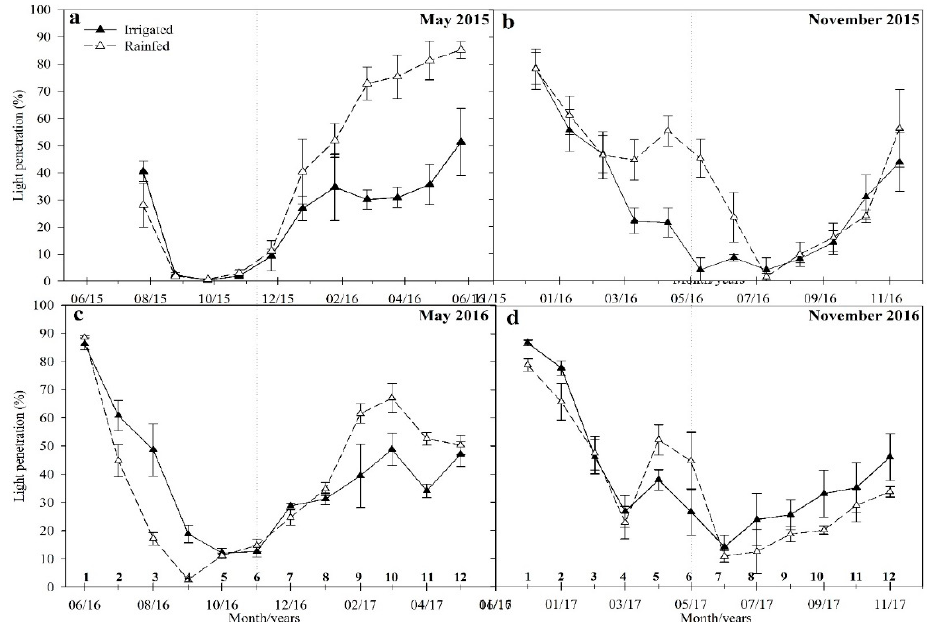
Figure 5. Light penetration of Rayong 9 cassava under irrigated and rainfed conditions after planting in ( a , c ) May and ( b , d ) November 2015 and 2016. The bar is standard deviation .